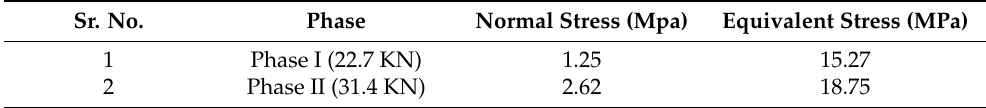
Table 7. Summary of computational approach.